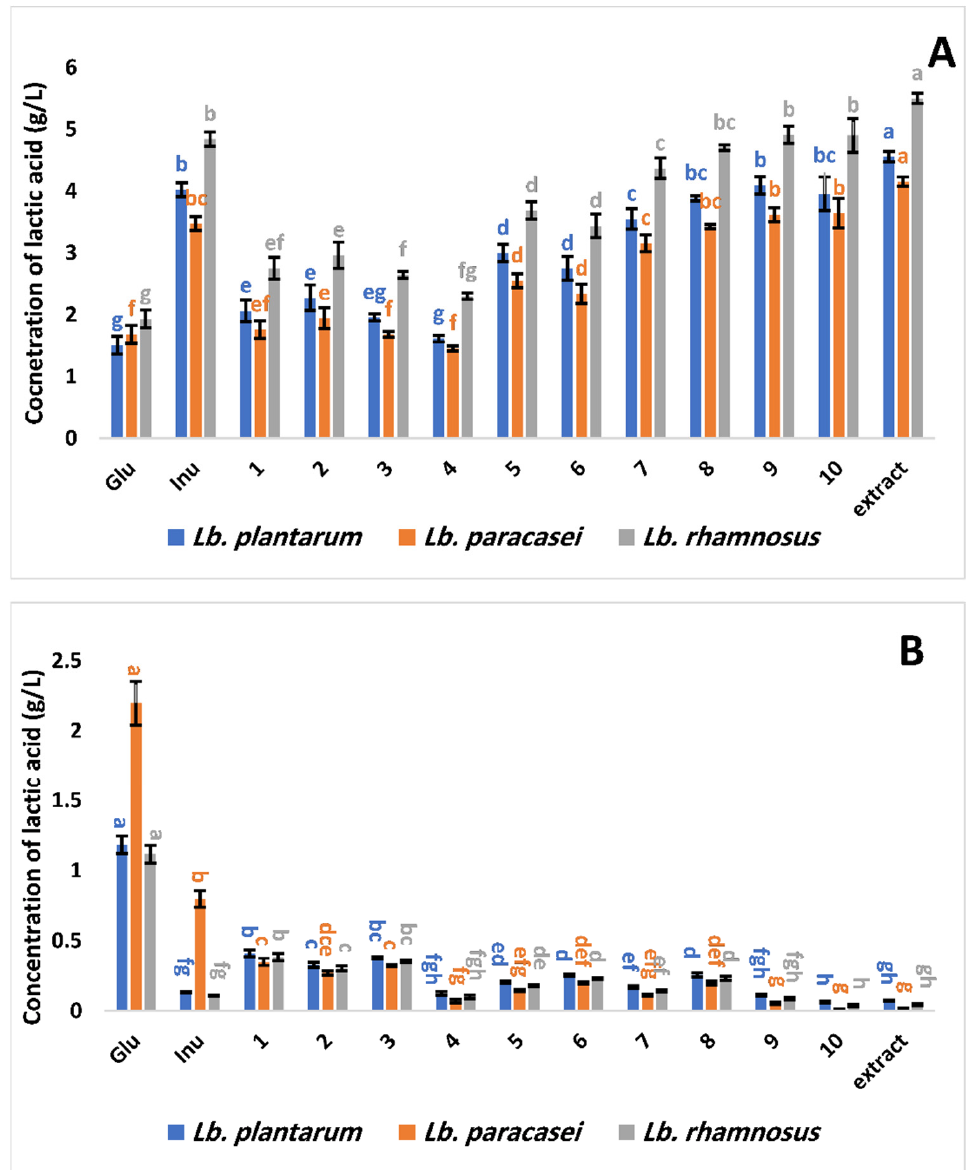
Figure 3. Effect of G. abyssinica extract and isolated bioactive compounds on probiotic bacteria’s ability to produce the optically active forms of lactic acid L (+) ( A ) and D (+) ( B ). Lowercase letters show a significant impact on the prebiotic activity index ( p ˂ 0.05). The standard deviation between the means of the treatments is shown by vertical bars.